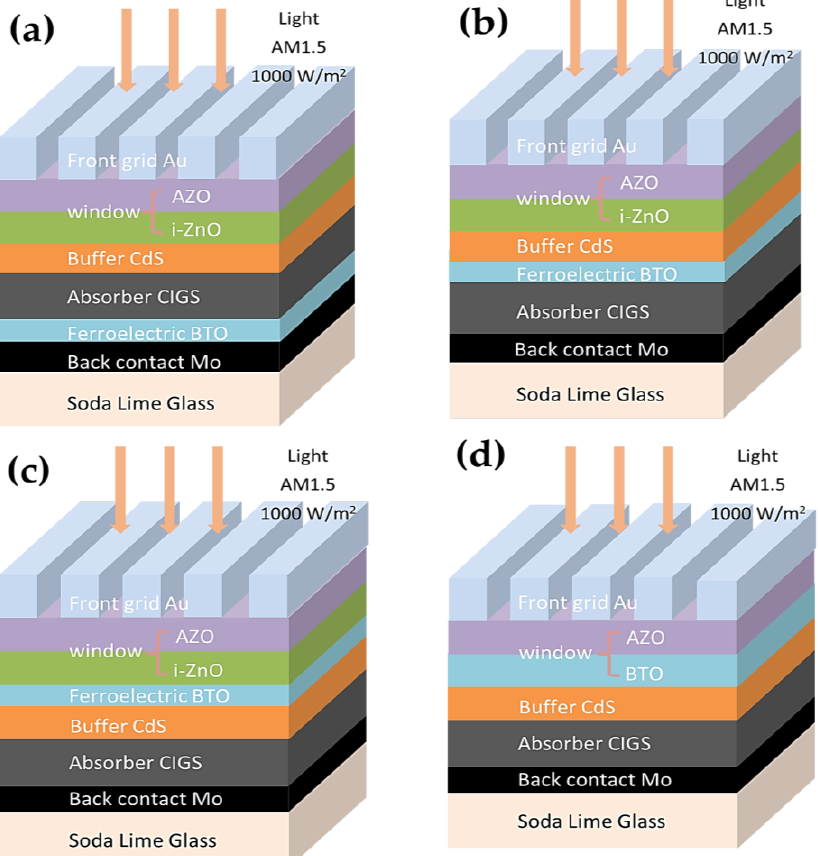
Figure 1. Device architectures for simulation: ( a ) SLG/Mo/BTO/CIGS/CdS/i-ZnO/AZO/Au, ( b ) SLG/Mo/CIGS/BTO/CdS/i-ZnO/AZO/Au, ( c ) SLG/Mo/CIGS/CdS/BTO/i-ZnO/AZO/Au, ( d ) SLG/Mo/CIGS/CdS/BTO/AZO/Au.